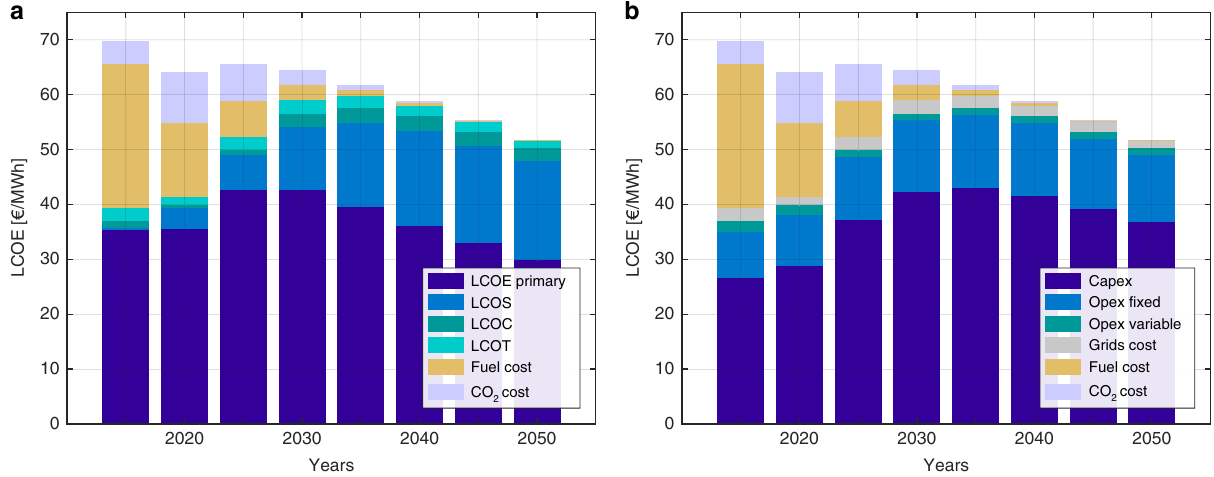
Fig. 5 Globally averaged electricity system LCOE for the transition period from 2015 to 2050. LCOE primary levelized cost of electricity generation, LCOS levelized cost of storage, LCOC levelized cost of curtailment, LCOT levelized cost of transmission. a Breakdown by system components. b Breakdown by cost components. The energy transition leads to lower cost electricity supply. Applied fi nancial and technical assumptions do not consider any breakthrough in ef fi ciency or cost development, only evolutionary improvements and extending existing trends (see Supplementary Material for assumptions and results for all major regions)